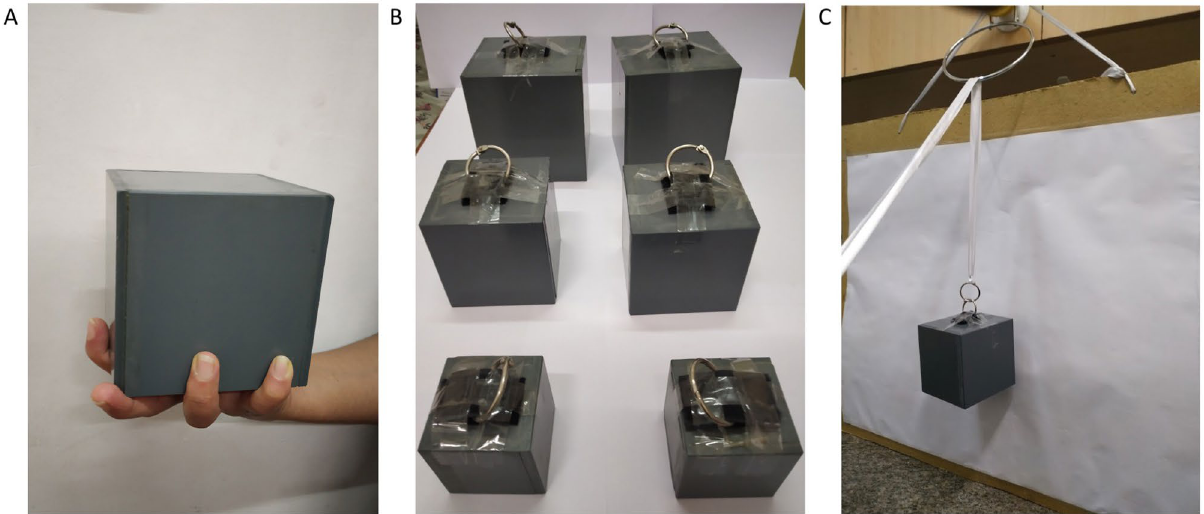
Figure 1. ( A ) Large-sized cube stimulus placed in the dominant hand, demonstrating the procedure for Experiment 1. ( B ) The six stimuli used in the study (front to back: Small, Medium, Large, 350 g and 700 g respectively), with attachments for Experiment 2. ( C ) String set-up of Experiment 2. A smooth ribbon is used to lift the cube during each trial, ensuring that only visual size cues are available to the